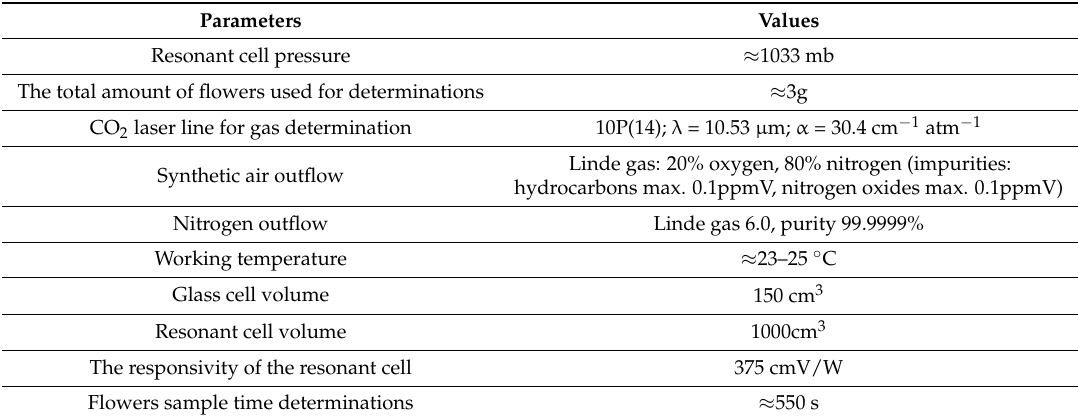
Table 1. Selecting parameters for ethylene gas determination at the flowers.